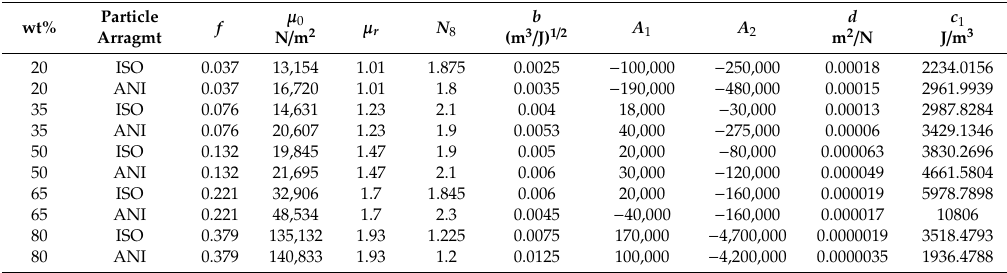
Table 2. Estimated material constant values of µ 0 , µ r , N 8 , b , A 1 , A 2 , d , and c 1 obtained by fitting experimental data with B = 52.2 mT.